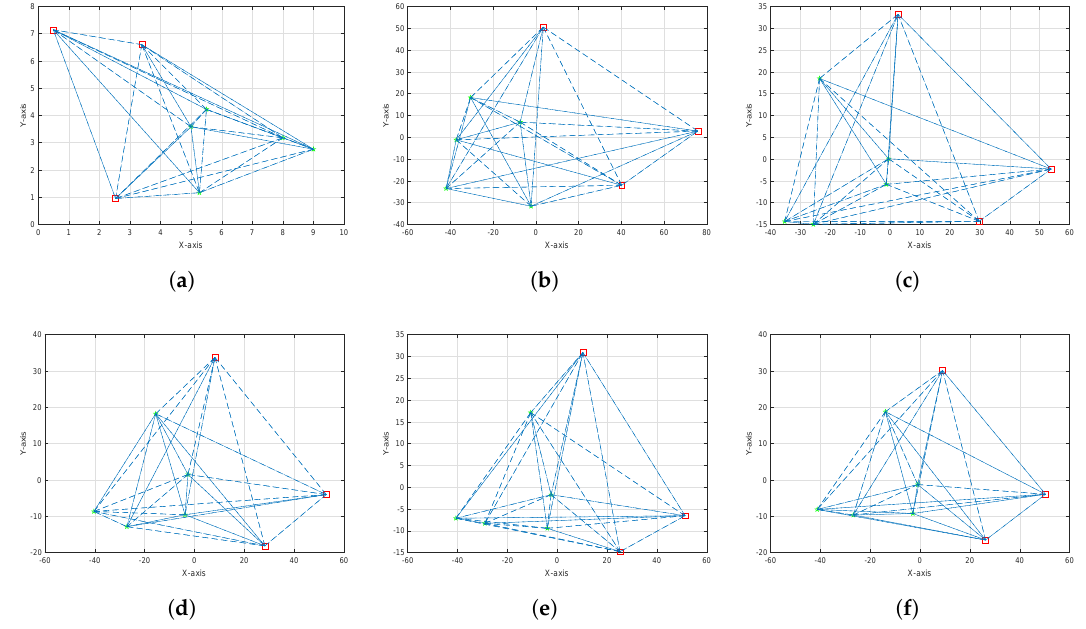
Figure 2. ( a ) Actual locations of the nodes for m = 3 and n = 5; ( b ) Single observation at σ 2 = 1.77 m; ( c ) Single observation at σ 2 = 0.5 m; ( d ) Single observation at σ 2 = 0.17 m; ( e ) Single observation at σ 2 = 0.05 m; ( f ) Multiple